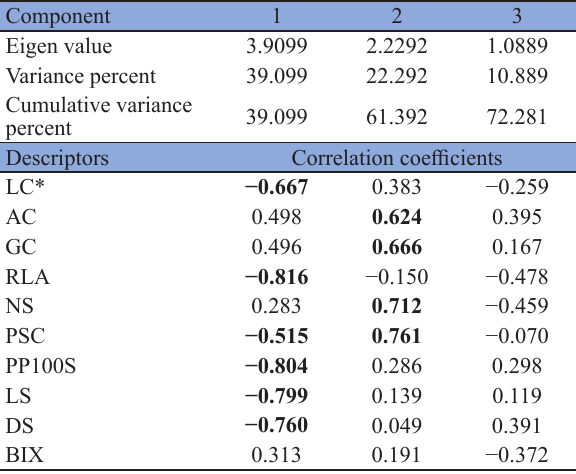
Table 7 . PCA output of the quantitative descriptors used to characterize achiote